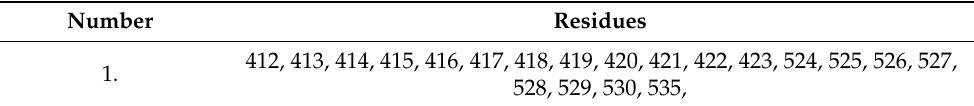
Table 2. Residues observed in the E2 model of HCV via COACH server and literature.